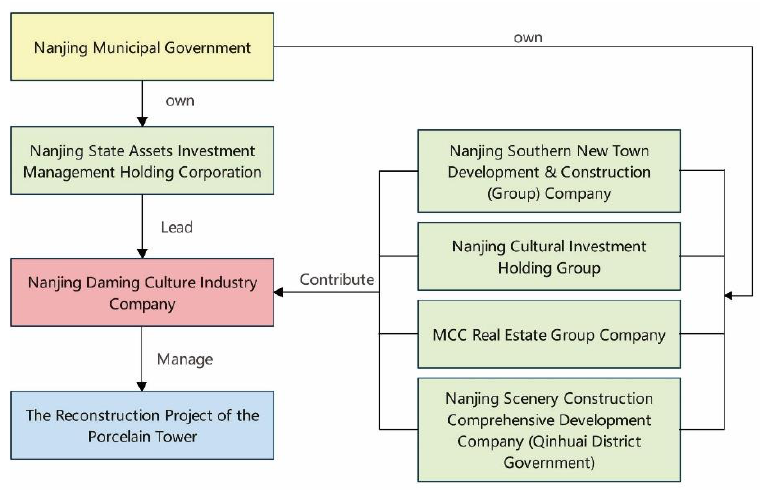
Figure 4. Organisation Chart for reconstruction of the Porcelain Tower (Source: the